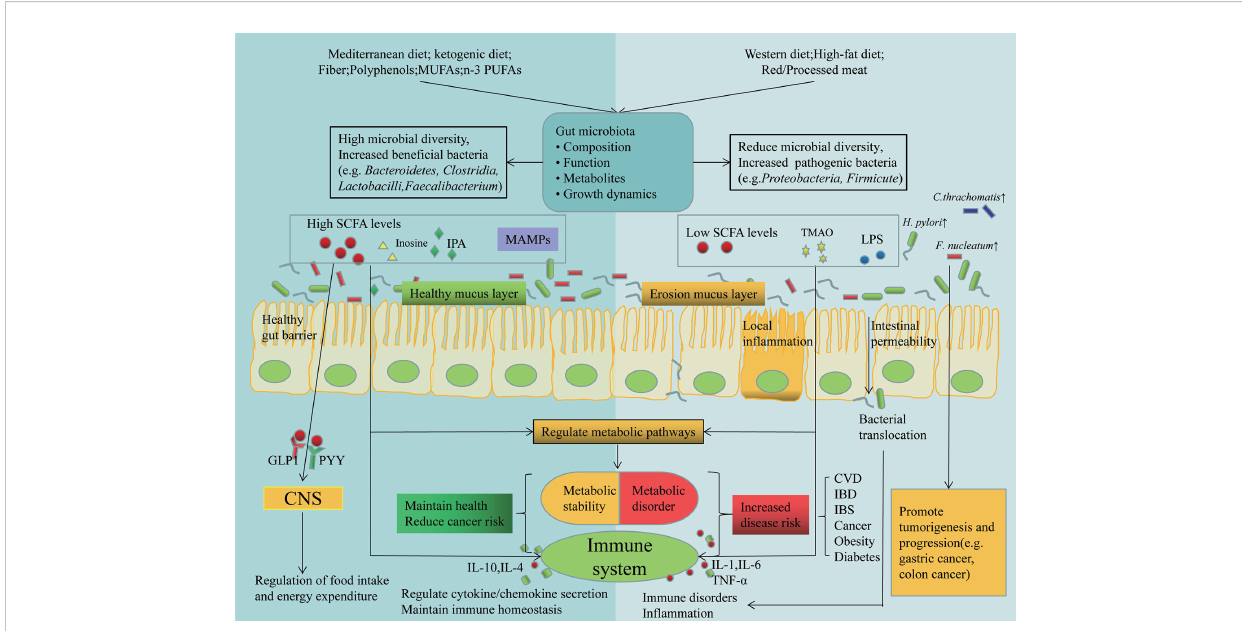
FIGURE 2 Dietary and gut microbial interactions regulate host immunity and metabolism. Different dietary patterns affect the composition of gut microbes and their metabolites, which are involved in the pathogenesis of many diseases by affecting host metabolism and immunity through different mechanisms. Also alterations in gut microbes in turn affect nutrition. Some tumor associated bacterascites (e.g. H. pylori, F. nucleatum and C. thrachomatis ), promote tumorigenesis and progression. GLP1, glucagon-like peptide 1; PYY, peptide tyrosine-tyrosine; IPA, indolepropionic acid; MAMPs, Metabolism-Associated Molecular Patterns; TMAO, Trimetlylamine